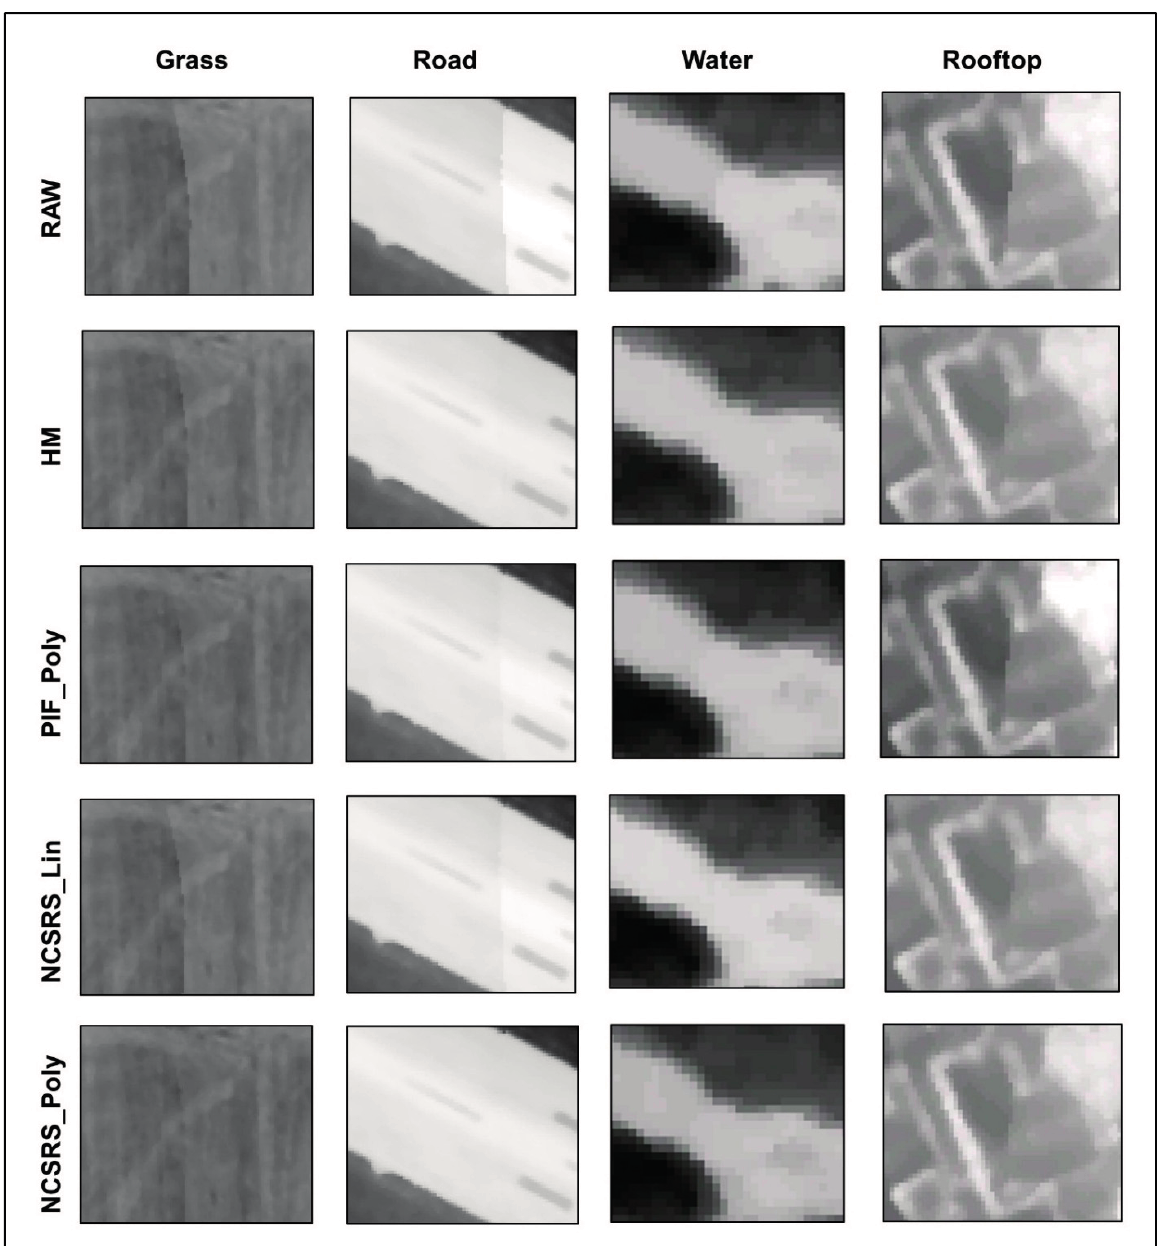
Figure 5. Visual examples of four different relative radiometric normalization methods applied along the mosaic join line of four different land cover types (grass, road, water and rooftop). PIF_Poly—pseudo-invariant feature-based polynomial